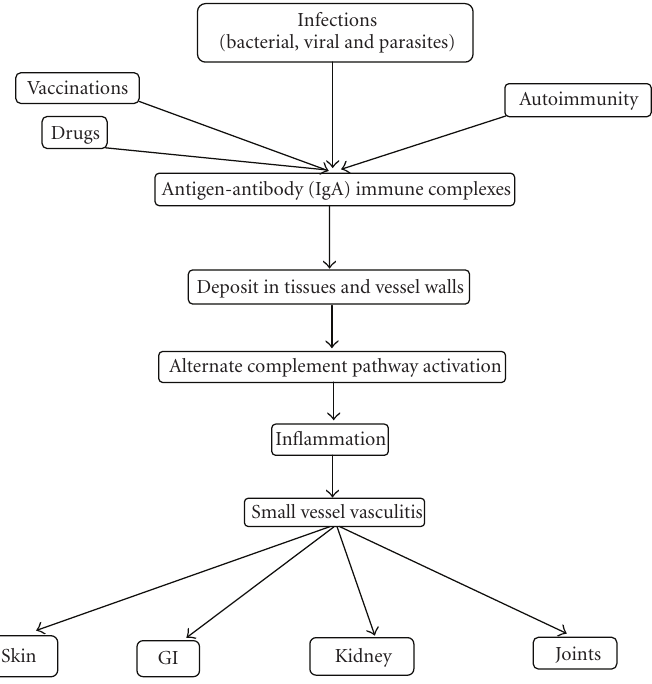
Figure 7: Schematic diagram of HSP pathophysiology. Table 2: Diagnostic criteria of HSP (ACR and EuLAR & PReS) [8, 9]. EuLAR/PReS criteria—2006